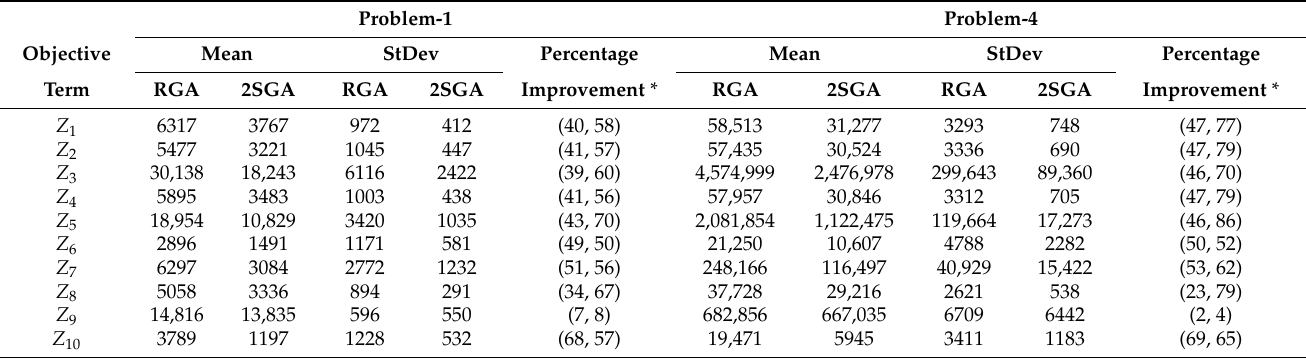
Table 13. The mean and standard deviation of the objective function terms in the initial population under RGA and